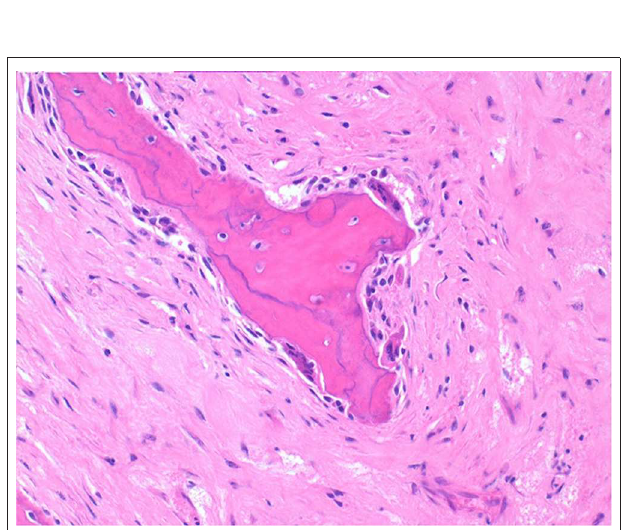
FIGURE 9 | Mandible, roe deer ( Capreolus capreolus ); cauliflower-like proliferations expanding from the gingival surface and rimming the lower premolars and molars.